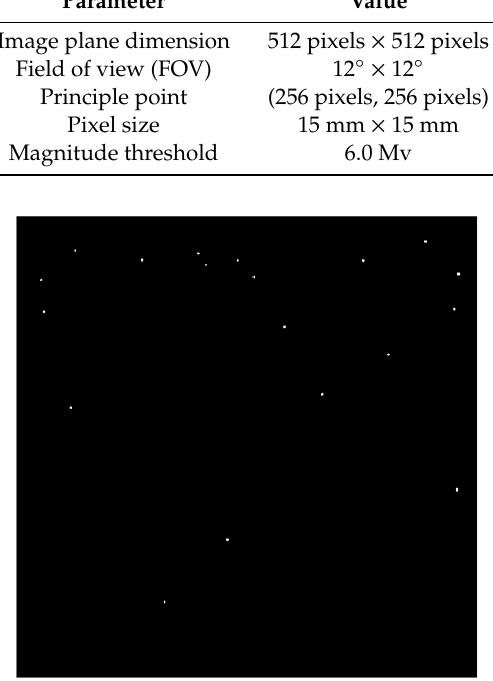
Figure 12. A simulated star image ( σ PSF = 0.3).